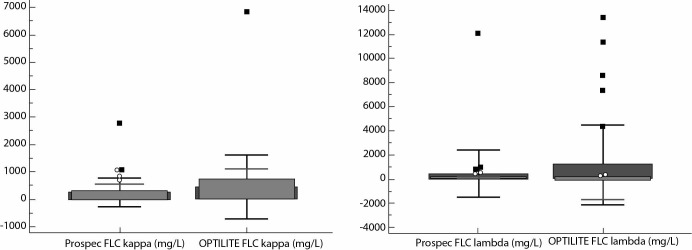
Distribution of kappa (A) and lambda (B) free light chaines (FLC) results in serum samples (N = 37) by two assays on ProSpec and Optilite analysers.